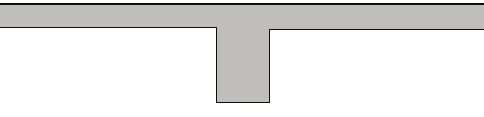
Figure 6: Simulated intruder